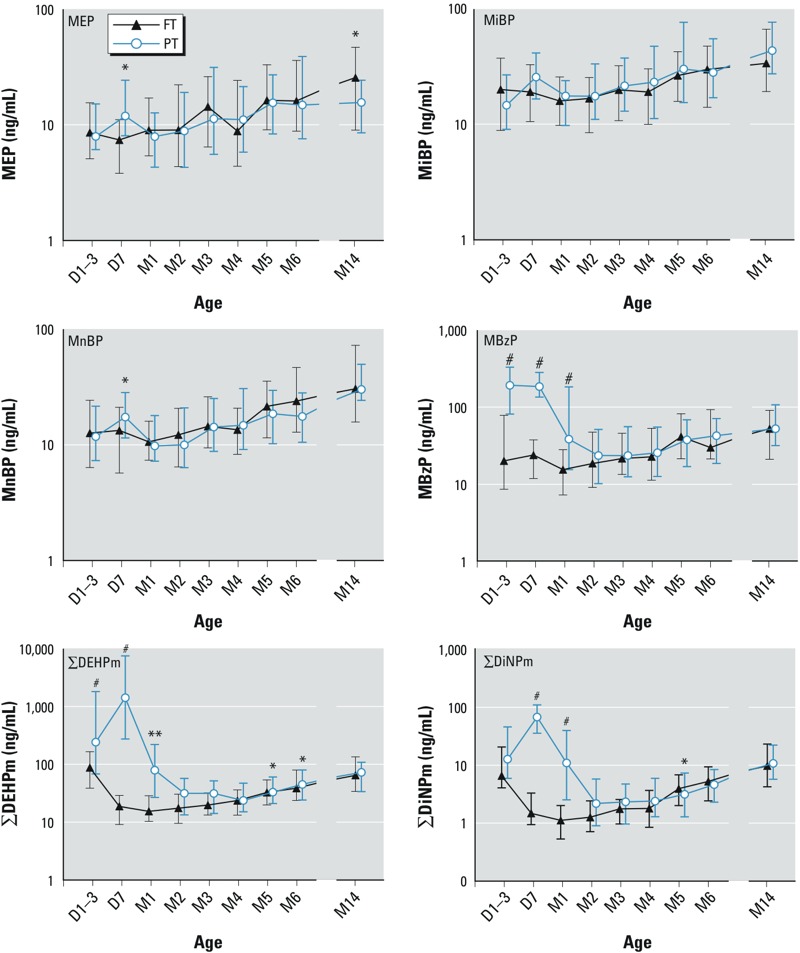
Median levels (error bars indicate the 25th–75th percentiles) of urinary phthalate metabolites in 432 samples (D1–3, n = 32; D7, n = 50; M1, n = 53; M2, n = 54; M3, n = 50; M4, n = 51; M5, n = 50; M6, n = 49; M14, n = 43) of FT and 462 samples (D1-3, n = 41; D7, n = 39; M1, n = 48; M2, n = 51; M3, n = 59; M4, n = 57; M5, n = 61; M6, n = 61; M14, n = 45) of PT infants according to age [day (D) and month (M)].
Symbols indicate statistical significance for group difference in the mixed-model analysis adjusted for weight (*p < 0.05, **p < 0.01, and #p < 0.001).